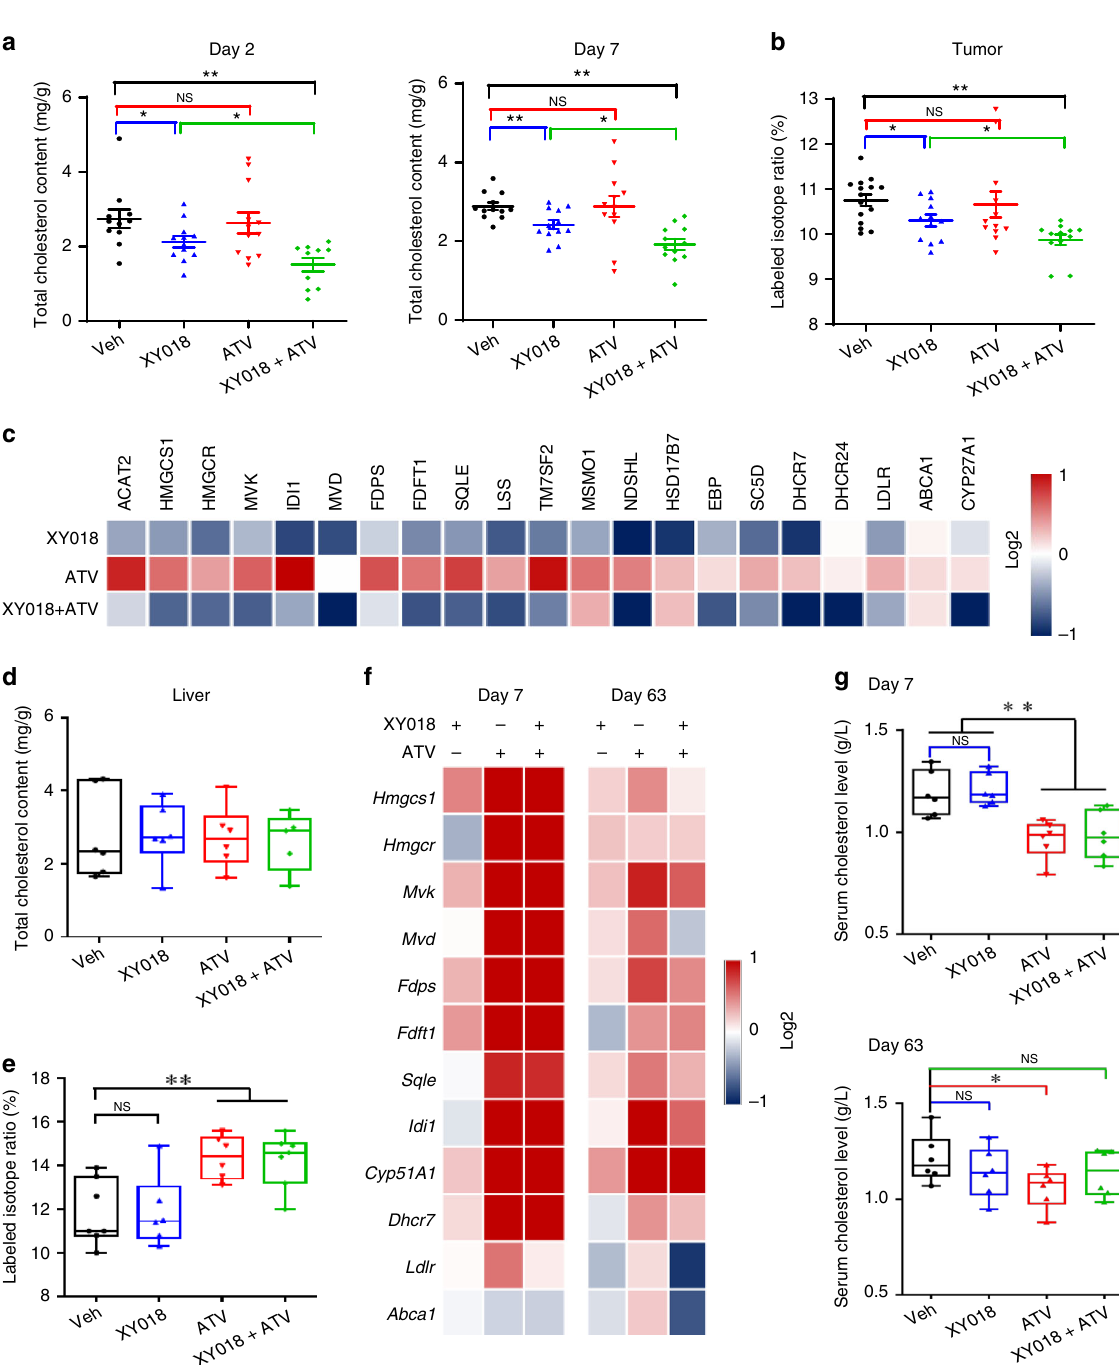
Fig. 7 ROR γ inhibitor reduces TNBC tumor cholesterol biosynthesis in vivo. a Total tumor cholesterol content from HCC70 tumor-bearing mice with indicated treatments for 2 or 7 days was analyzed after organic extraction. n = 12 – 14 tumors per group. b Labeled isotope ratio indicating tumor cholesterol biosynthesis rate was measured with GC – MS quantifying deuterated hydrogen incorporation into the newly synthesized cholesterol molecules. HCC70 tumor-carrying mice were treated with XY018, ATV, or both as indicated, then dosed with deuterium oxide for 2 h before tissues were collected. n = 7 mice per group. c Heat map display of fold changes (in log2) of cholesterol-biosynthesis pathway gene mRNA analyzed by qRT-PCR in tumors from HCC70 tumor-bearing mice with indicated treatments for 7 days. n = 7, the experiments were repeated three times. d Total liver cholesterol content from mice in ( a ) with indicated treatments for 7 days. n = 7. e Labeled isotope ratio of liver cholesterol biosynthesis rate in the mice as in ( b ). n = 7. f Heat map display of fold changes (in log2) of cholesterol-biosynthesis pathway gene mRNA analyzed by qRT-PCR in livers from TNBC tumor-bearing mice with indicated treatments for 7 or 63 days. n = 7, the experiments were repeated three times. g Total cholesterol levels in serum from mice as in ( f ) were measured. From a to g , 20 mg/kg XY018 or 15 mg/kg ATV were used. Data are shown as mean ± s.e.m. Student ’ s t test. ∗ p < 0.05, ∗∗ p < 0.01, NS not signi fi